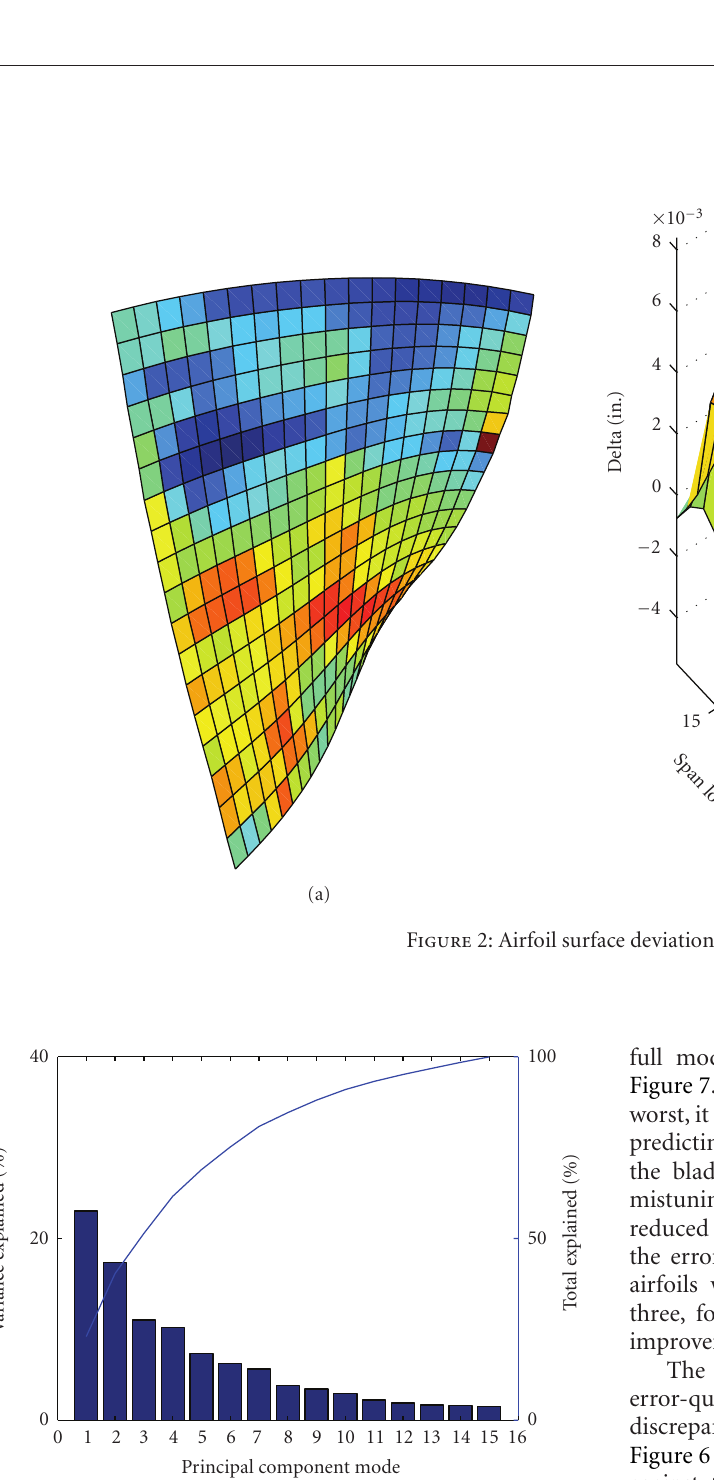
Figure 3: Total variance explained by principal